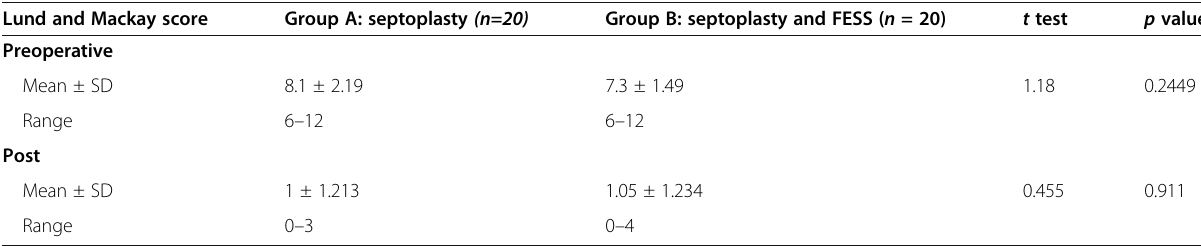
Table 1 Comparison between group A: septoplasty and group B: septoplasty and FESS as regards the pre-operative and post- operative Lund and Mackey score